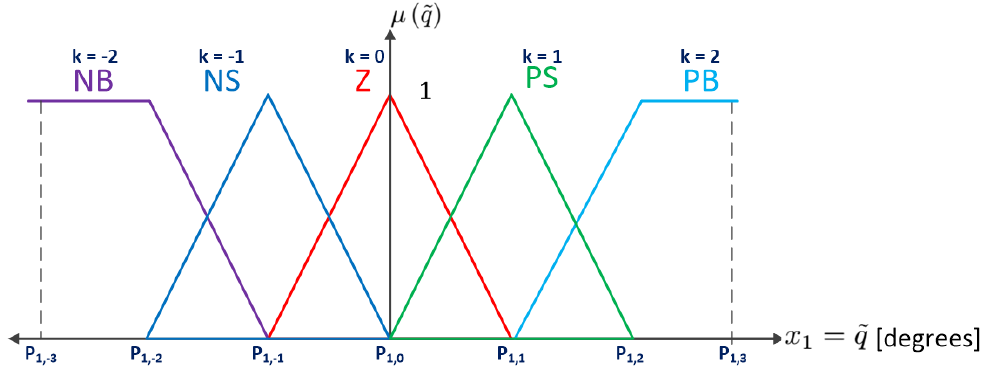
Figure 10. Fuzzy sets for input x 1 = ˜ q i .